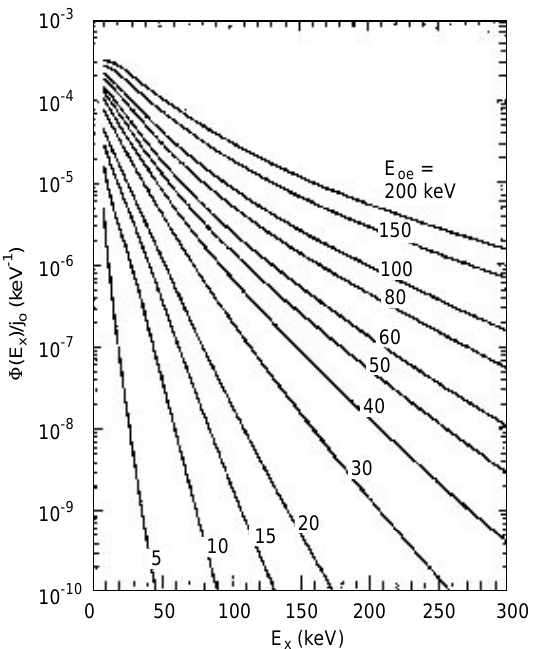
Fig. 5. The X-ray energy spectrum, (cid:85) (cid:133) E x (cid:134) = j o , normalized to incident integral electron flux (cid:133) j o (cid:134) , produced by di(cid:128)erent exponential electron distributions, calculated from the electron di(cid:128)erential energy spectra. E o e is the electron e-folding energy (Seltzer and Berger, 1974)